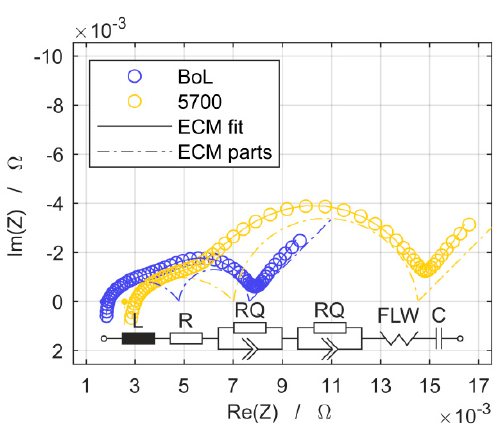
Figure 2. Electrochemical impedance measurement results for both, the begin of life (BoL) state and after 5700 theoretical cycles, as well as the graphs of the equivalent circuit model (ECM) fit and its individual elements for both cases.